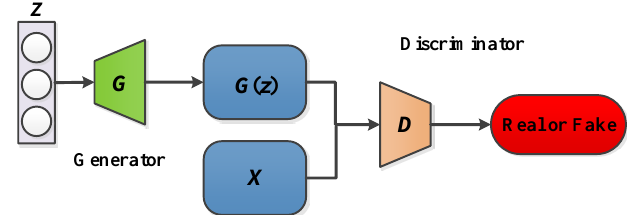
Figure 1. GAN network structure diagram.